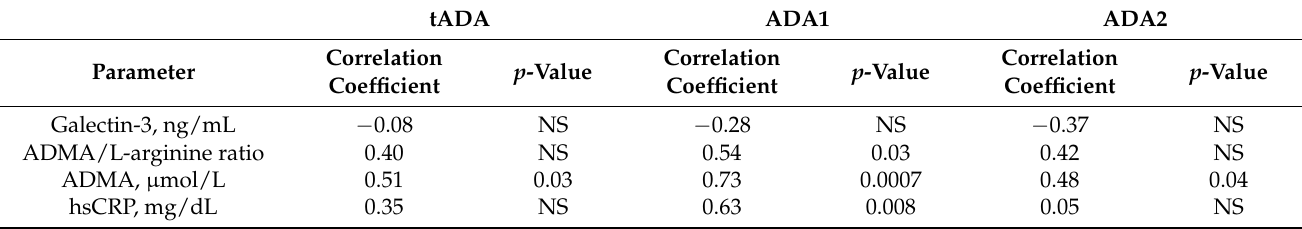
Figure 6. Plasma macrophage polarization markers in breast cancer patients. Plasma concentration of soluble CD163 protein (sCD163, A ) and galectin 3 (Gal3, B ) in healthy controls ( n = 18), HR+ HER2+ BC ( n = 12), HR+ HER2- BC ( n = 16), and triple negative (TNBC, n = 19) breast cancer patients ( C ). Correlation plots of plasma sCD163 with tADA, ADA1, and ADA2 activities in TNBC ( D ). Results are shown as mean ± SEM, * p < 0.05 by one-way ANOVA followed by Holm-Sidak post hoc test ( A ), Kruskal-Wallis test followed by Dunn’s post hoc test ( B ) and as Pearson correlation coefficients with corresponded p -value ( C ). Table 3. Clinical correlations in TNBC patients with the activities of plasma ADA